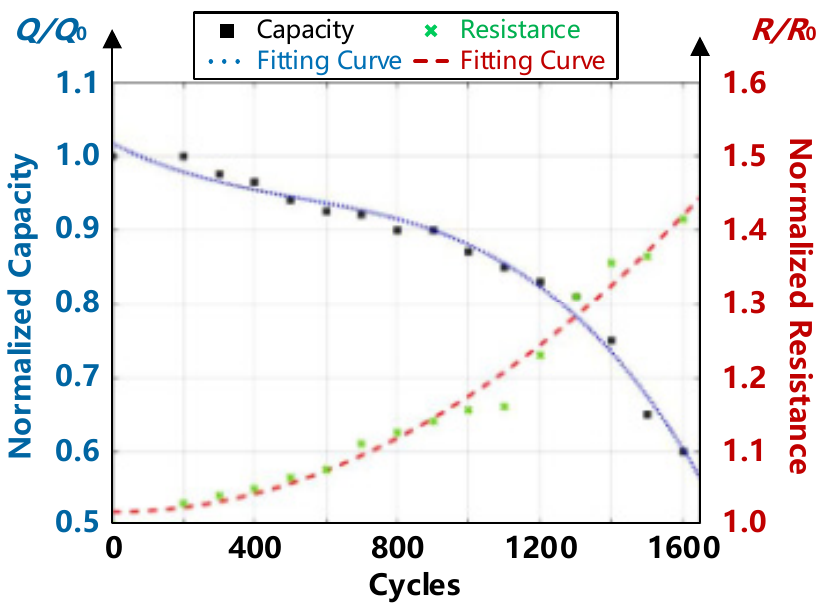
Figure 5. Normalized capacity/resistance curve as a function of cycles [2].